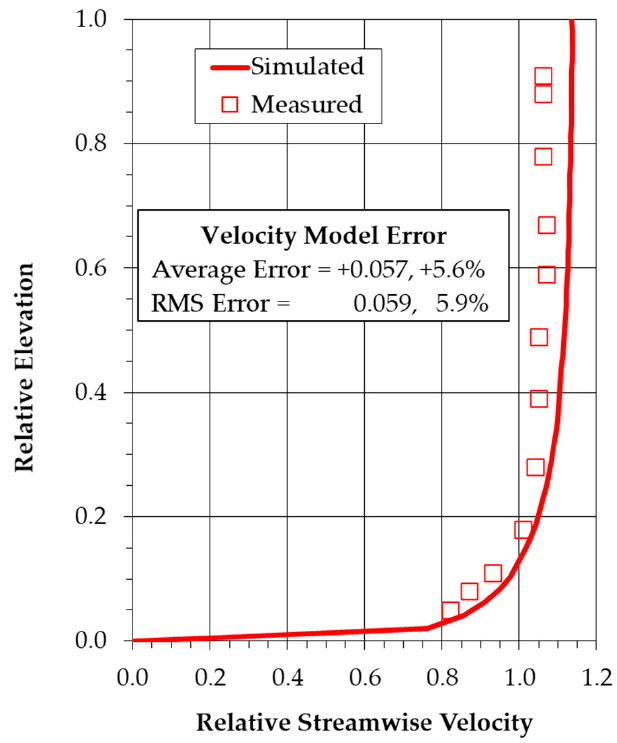
Figure 9. Comparison of simulated and measured velocity profile at cross-section S0 at position − 0.461 B.